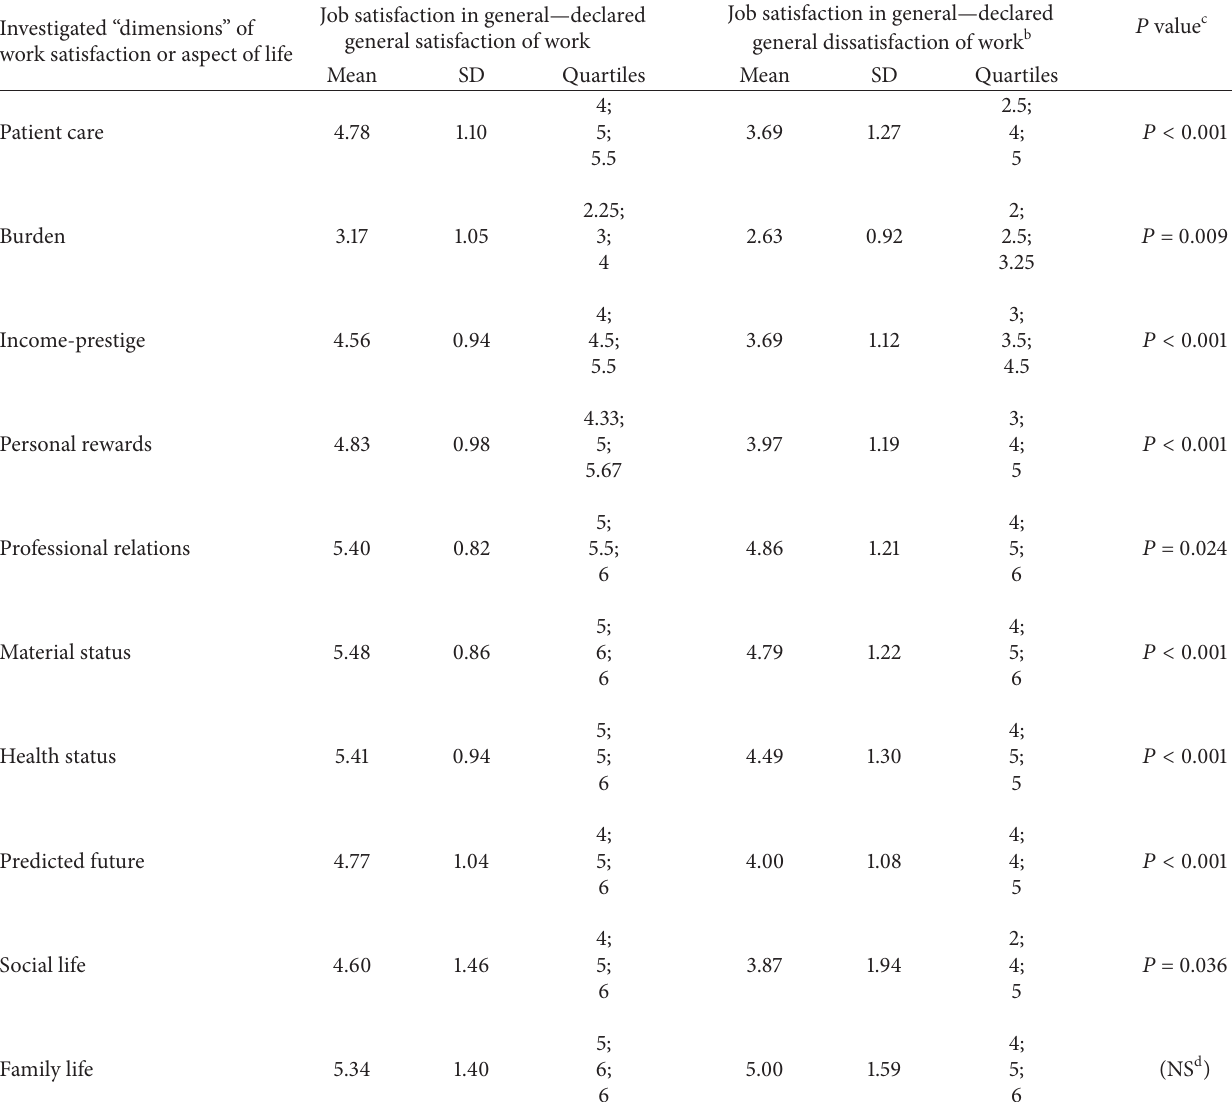
Table 1: Computed statistical parameters (mean, SD, and quartiles) for each averaged scoring referring to patient care, burden, income- prestige, personal rewards, and professional relations and different aspects of life among surveyed anesthesiologists being generally satisfied versus dissatisfied a,b,c